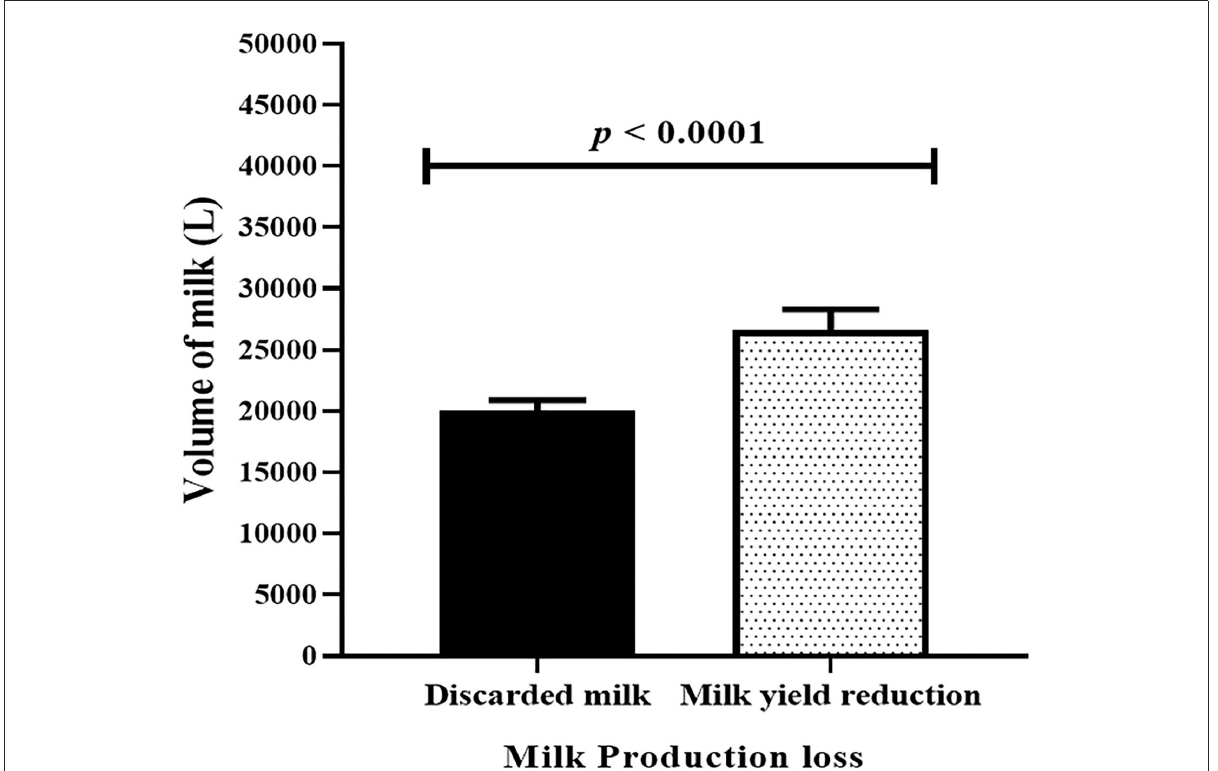
FIGURE8 Comparison of monthly discarded milk and monthly reduced milk production due to lactating cows affected by clinical mastitis. Black solid bar error represents mean ( ± SEM) of monthly discarded milk while dotted solid bar error represents monthly reduced milk production due to clinical mastitis. The monthly reduced milk yield was significantly (paired t- test, t = 4.8, p < 0.0001) higher than monthly discarded